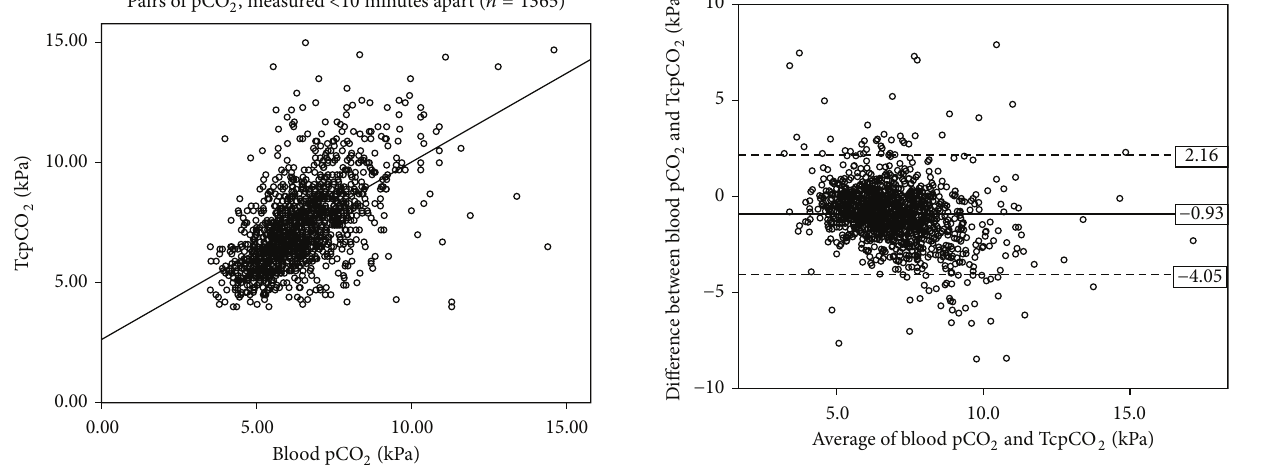
Figure 2: Bland-Altman plot of the average TcpCO 2 and blood pCO 2 values. Bland-Altman plot of the average TcpCO 2 and blood pCO 2 values ( 𝑥 -axis) and difference between TcpCO 2 and blood pCO 2 values ( 𝑦 -axis). 𝑛 = 1365 . Mean bias = − 0.93 kPa and 95% confidence limit of agreement = − 4.05 to +2.16kPa.